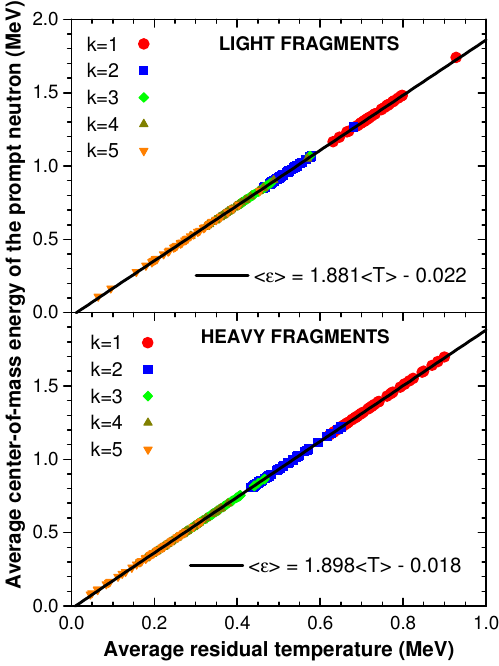
Fig.2 : Average centre-of-mass energy of each emitted neutron < ε > k (different symbols for k from 1 to 5) as a function of the average residual temperature <T k >. The linear fits are given with black